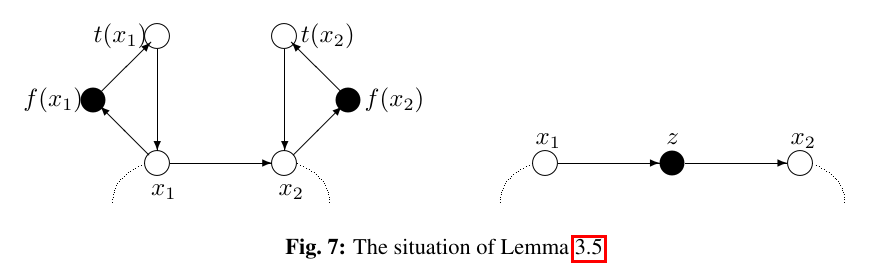
Fig. 7: The situation of Lemma